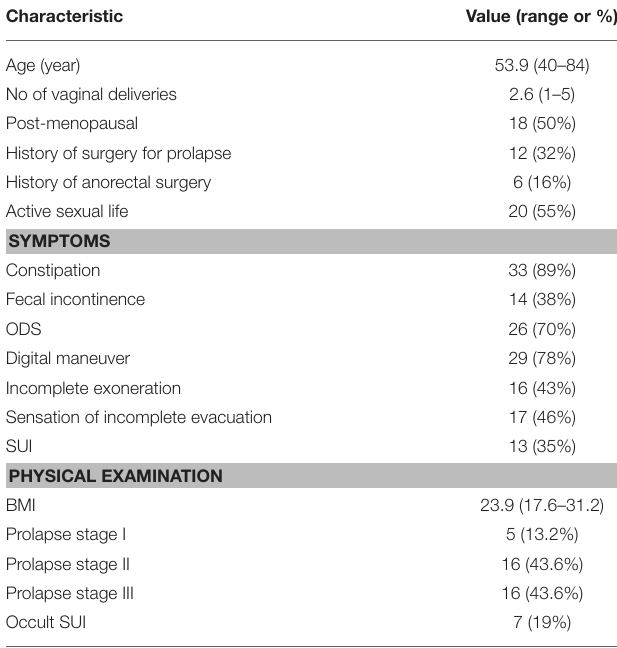
concavity and fixed to the promontory tension-free. The Douglas pouch is then incised and the rectovaginal space is dissected until reaching the central fibrous perineal body. The ventral prerectal mesh is fixed laterally to the levator muscles, to the anterior rectal and to the promontory without tension. We perform the vesico vaginal dissection, suture the vesico vaginal mesh to the vagina perform a reperitonisation (15) ( Figure 1 ).